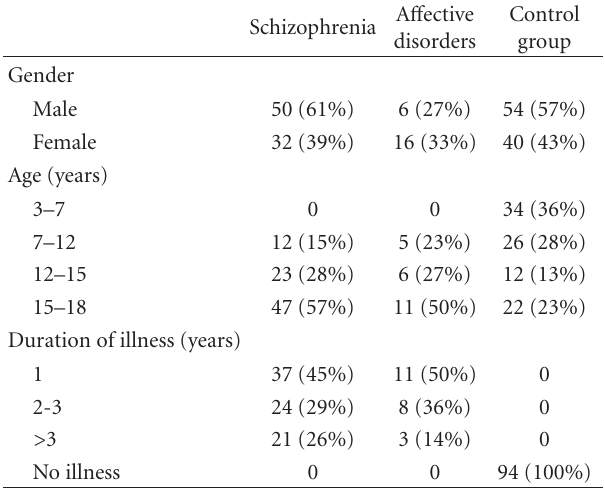
Table 2: Demographic characteristics of patients groups. Table 3: Correlation ( r ) of Hcy concentration between control group and psychiatric disorder